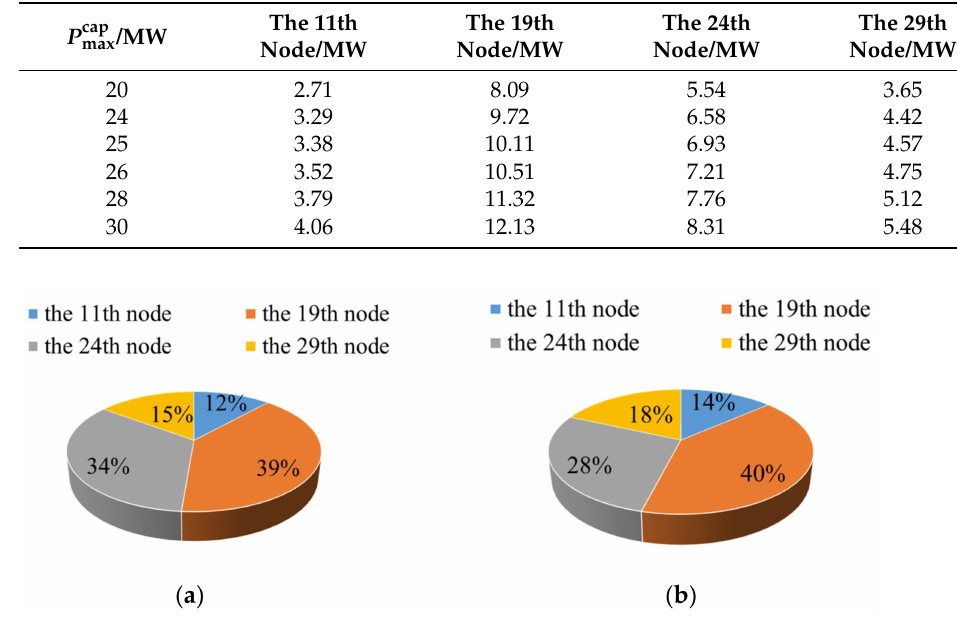
Table 3. Allocation schemes under different quota capacities.